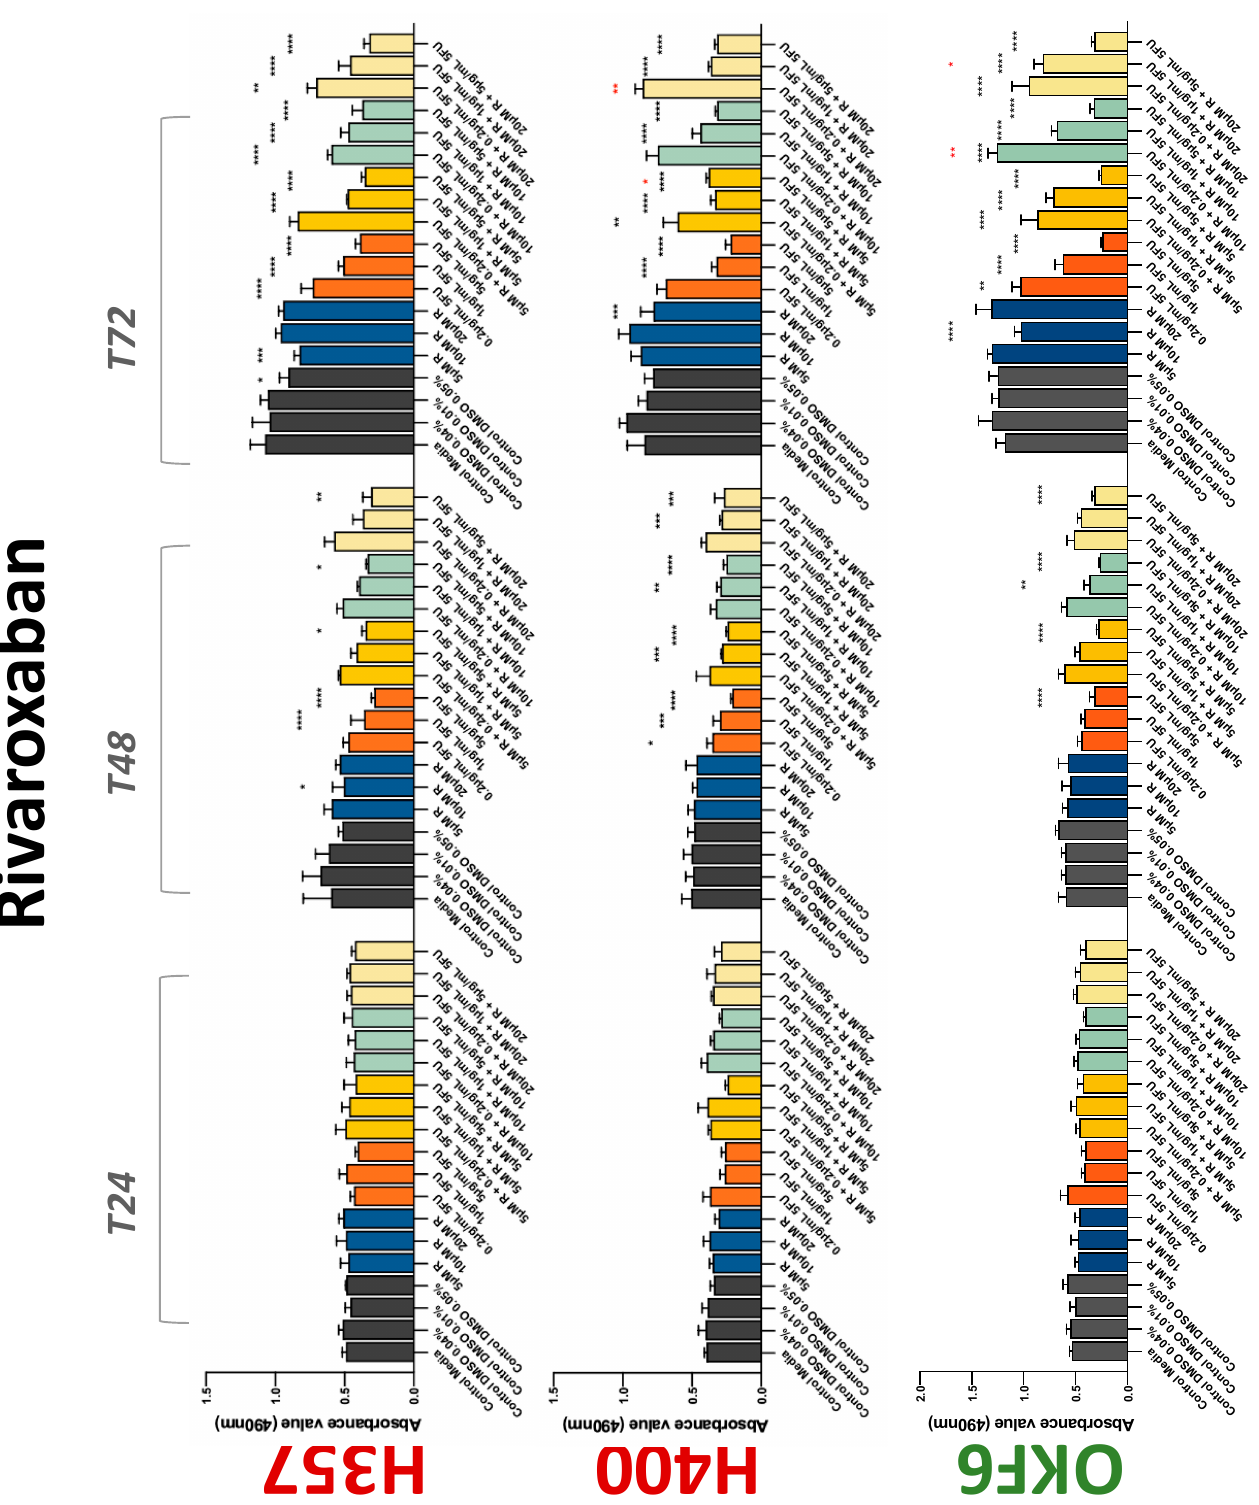
Figure 6 . MTS assay . The effect of (5/10/20 μ M) rivaroxaban and (0.2/1/5/10 μ g/mL) 5-FU on H357, H400, and OKF6 cell proliferation. Data are represented as mean ± SD. Statistical significance is given as follows: * p < 0.05, ** p < 0.01, *** p < 0.005, **** p < 0.001; * (black) compared to control group; * (red) compared to respective 5-FU groups. To assess if the anticoagulant effects observed were specific to oral malignant cells, the normal human keratinocyte cell line OKF6 was used as normal control in this study.